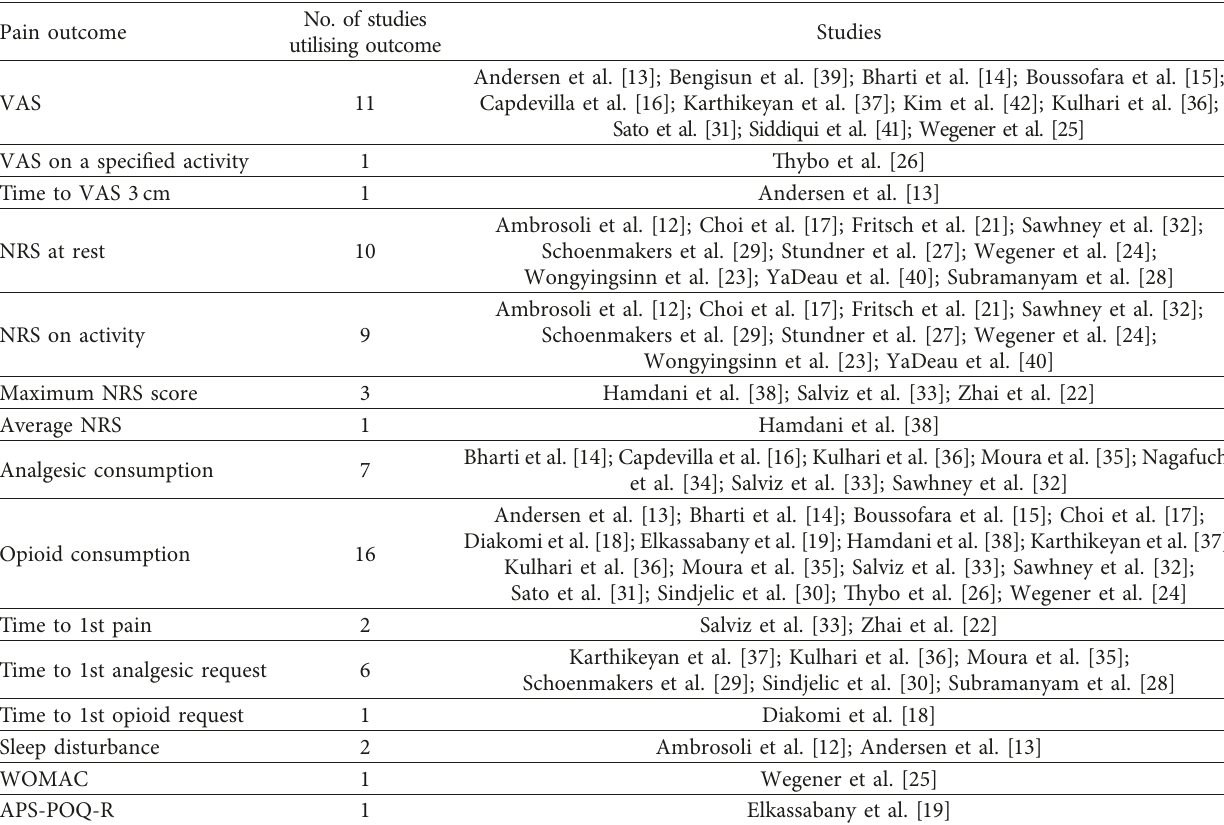
Table 2: Summary of pain outcomes reported in included